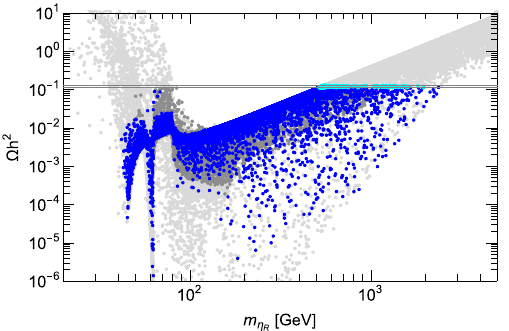
Fig. 3 Relic abundance (cid:8) η h 2 as a function of the η R mass. Blue R points denote solutions with viable relic density, although leading to underabundant dark matter. Cyan points fall within the 3 σ C.L. cold dark matter measurement by the Planck collaboration [54,55]. Grey dots are excluded by at least one of the bounds in Sect. 3.2. Dark grey points are in conflict with the current limit on WIMP-nucleon SI elastic scattering cross section set by XENON1T